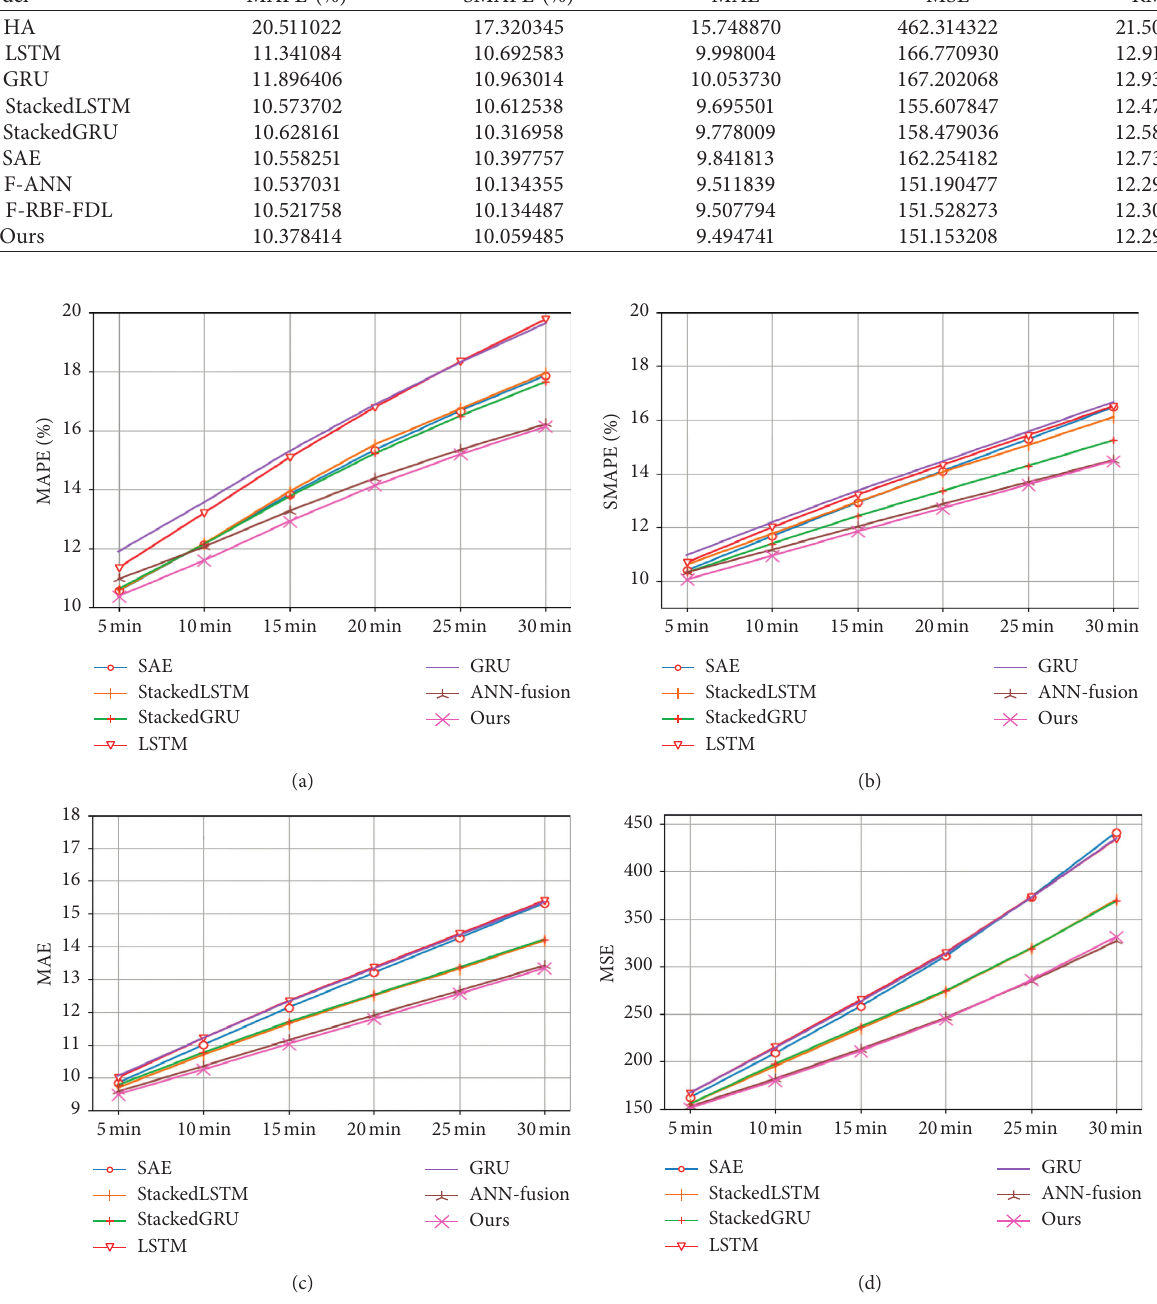
Figure 9: The changing indicators of models in multiple steps.